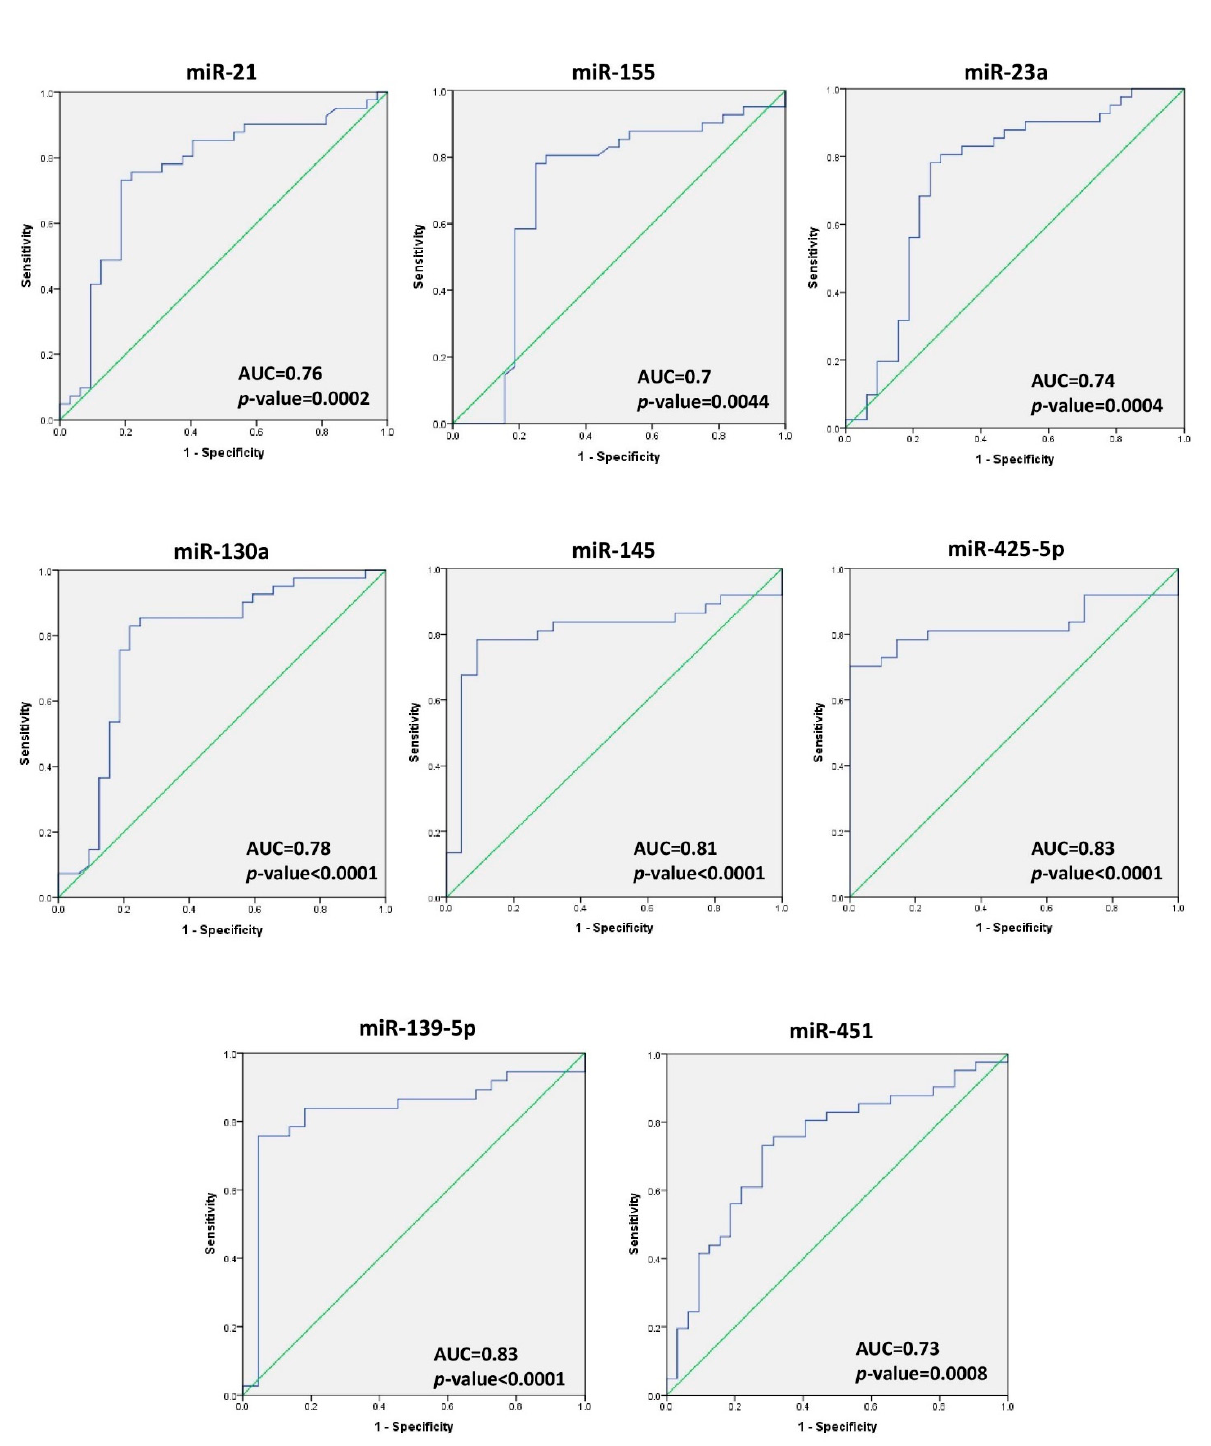
Figure 3. Diagnostic accuracy of miR ‐ 21, miR ‐ 130a, miR ‐ 155, miR ‐ 23a, miR ‐ 145, miR ‐ 425 ‐ 5p, miR ‐ 139 ‐ 5p, and miR ‐ 451 for BC detection in plasma. The ROC curve analysis separates between BC patients and healthy controls through individual miRNA. p < 0.05 indicates significance. For miR ‐ 21, miR ‐ 130a, miR ‐ 155, miR ‐ 23a, and miR ‐ 451, the number of tumor samples = 41 and the number of healthy samples = 32. For miR ‐ 145, miR ‐ 425 ‐ 5p, and miR ‐ 139 ‐ 5p, the number of tumor samples = 37 and the number of healthy subjects = 21.